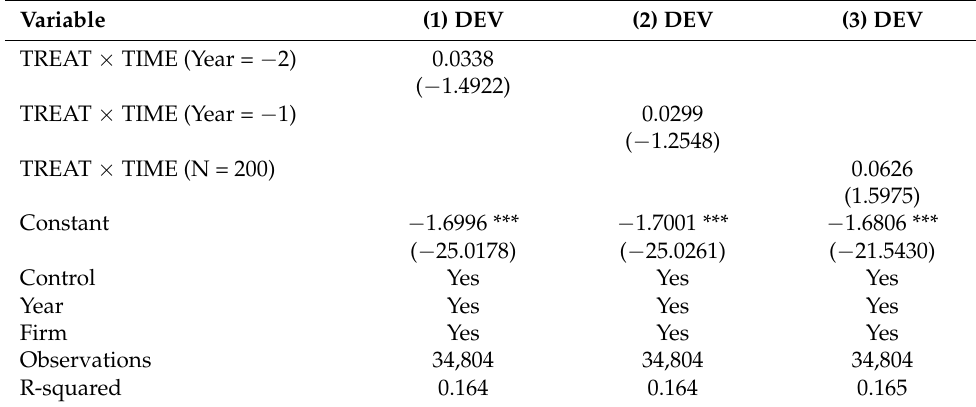
Table 10. Placebo test.